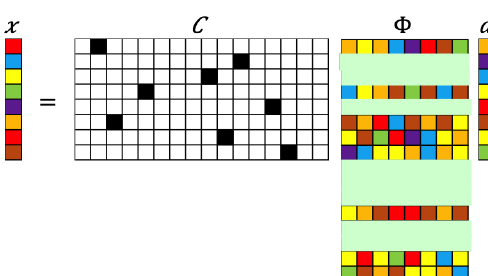
Figure 2. Schematic illustration of sparse sensor placement. The pastel colored rectangles represent rows activated by the sensors denoted in the measurement matrix through dark